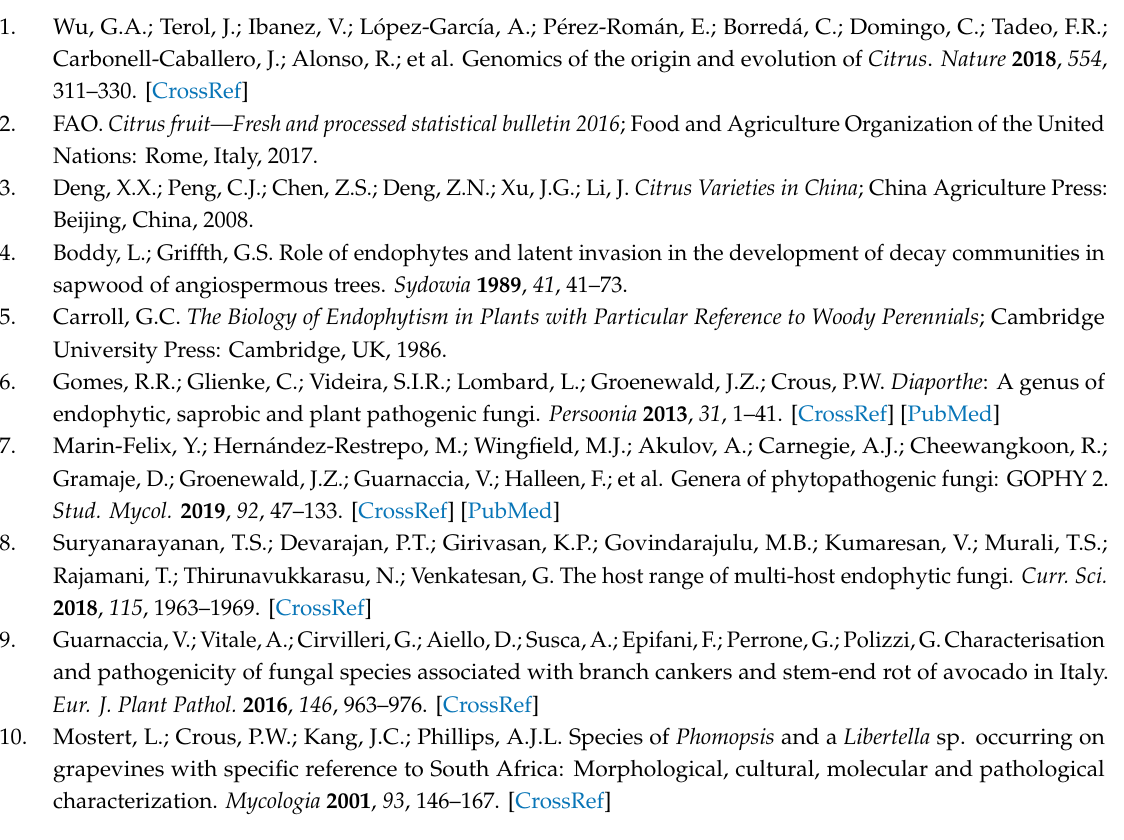
Table S1: Checklist of Diaporthe citri and D. infertilis associated with details citrus host and their allied genera, locality and their reference(s), Figure S1: Phylogenetic trees of Diaporthe spp. by Bayesian inference (BI) analysis based on combined data set and individual locus (ITS, TUB, TEF, CAL , and HIS , respectively). Ex-type, ex-isotype, and ex-epitype strains are indicated in bold. The species Diaporthella corylina (CBS 121124) was selected as an outgroup, Figure S2: Phylogenetic tree of Diaporthe spp. generated by Maximum Parsimony (MP) analysis based on combined data set and individual locus (ITS, TUB , TEF , CAL , and HIS , respectively). Ex-type, ex-isotype, and ex-epitype strains are indicated in bold. The species Diaporthella corylina (CBS 121124) was selected as an outgroup, Figure S3: The prevalence of Diaporthe species on citrus in Jiangxi Province, China based on phylogenetic identification. Number (%) indicate the number of obtained isolates of certain species and the percentage among the total 140 isolates. Figure S4: Species-specific 217 bp TUB gene amplified by the primer pair TUBDcitri-F1 / TUBD-R1 was shown with 2% gel electrophoresis. Thirty-eight representatives that were identified based on phylogenetic analysis were used to confirm the specificity of PCR approach. The numbers of D. citri, D. citriasiana, D. discoidispora, D. eres, D. sojae, and D. unshiuensis isolates were 10, 3, 5, 10, 5, and 5, respectively. Lane CK is the double sterile water (ddH 2 O) as negative control and lane M, 100 bp